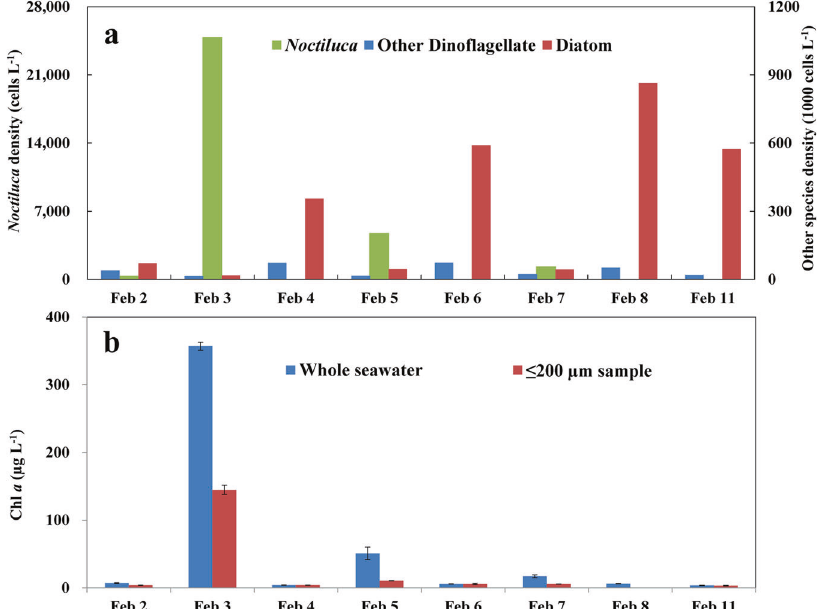
Fig. 1 g Noctiluca and phytoplankton dynamics in the study period during a bloom at Seeb Jetty, Muscat, Sultanate of Oman. a Contrasting cell abundances (cells L − 1 ) between g Noctiluca and phytoplankton functional groups. b Chlorophyll a (Chl a ) concentration (µg L − 1 ) for whole seawater and ≤ 200 µm size fraction (excluding most g Noctiluca cells). Error bar stands for standard